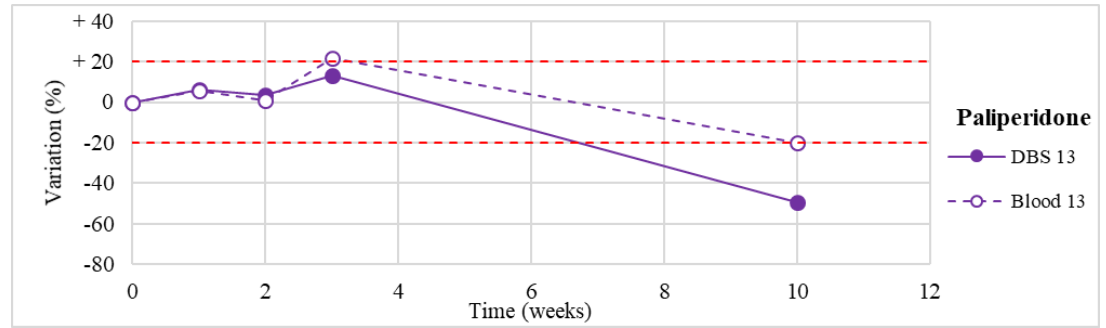
Figure 17. Long-term stability of pimozide ( n = 1) in DBSs stored at room temperature and in blood stored at −20 °C.